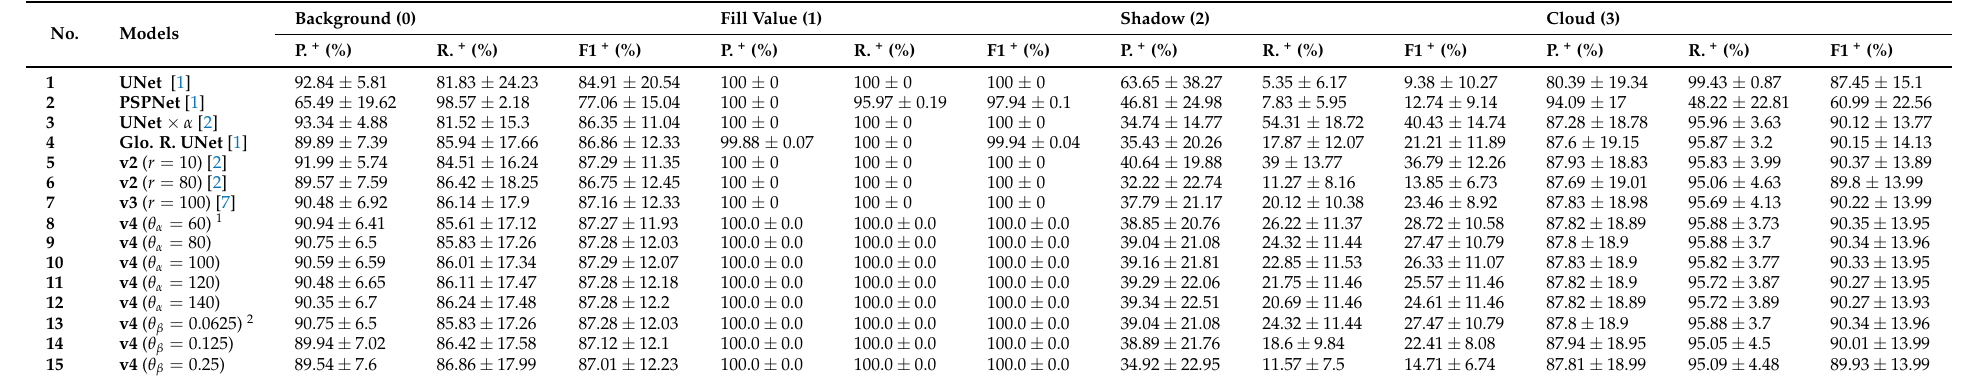
Table 2. Average Precision, Recall, and F1 Scores on Our Landsat 8 OLI Test Set (Mean ± Standard Deviation, + represents that higher scores indicate better